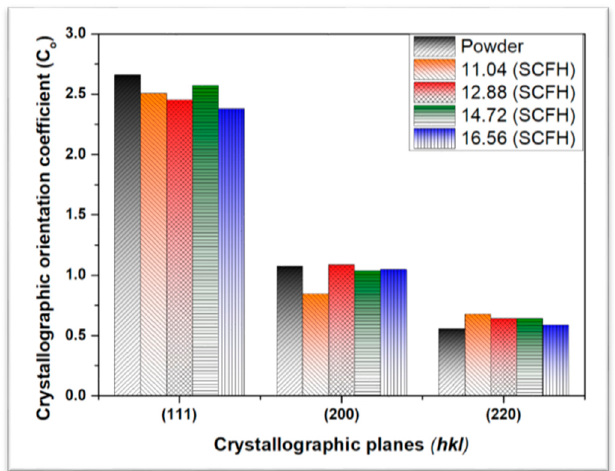
Figure 1. Crystallographic orientation coefficient of NiTec powder and coatings deposited under different oxygen flow conditions.